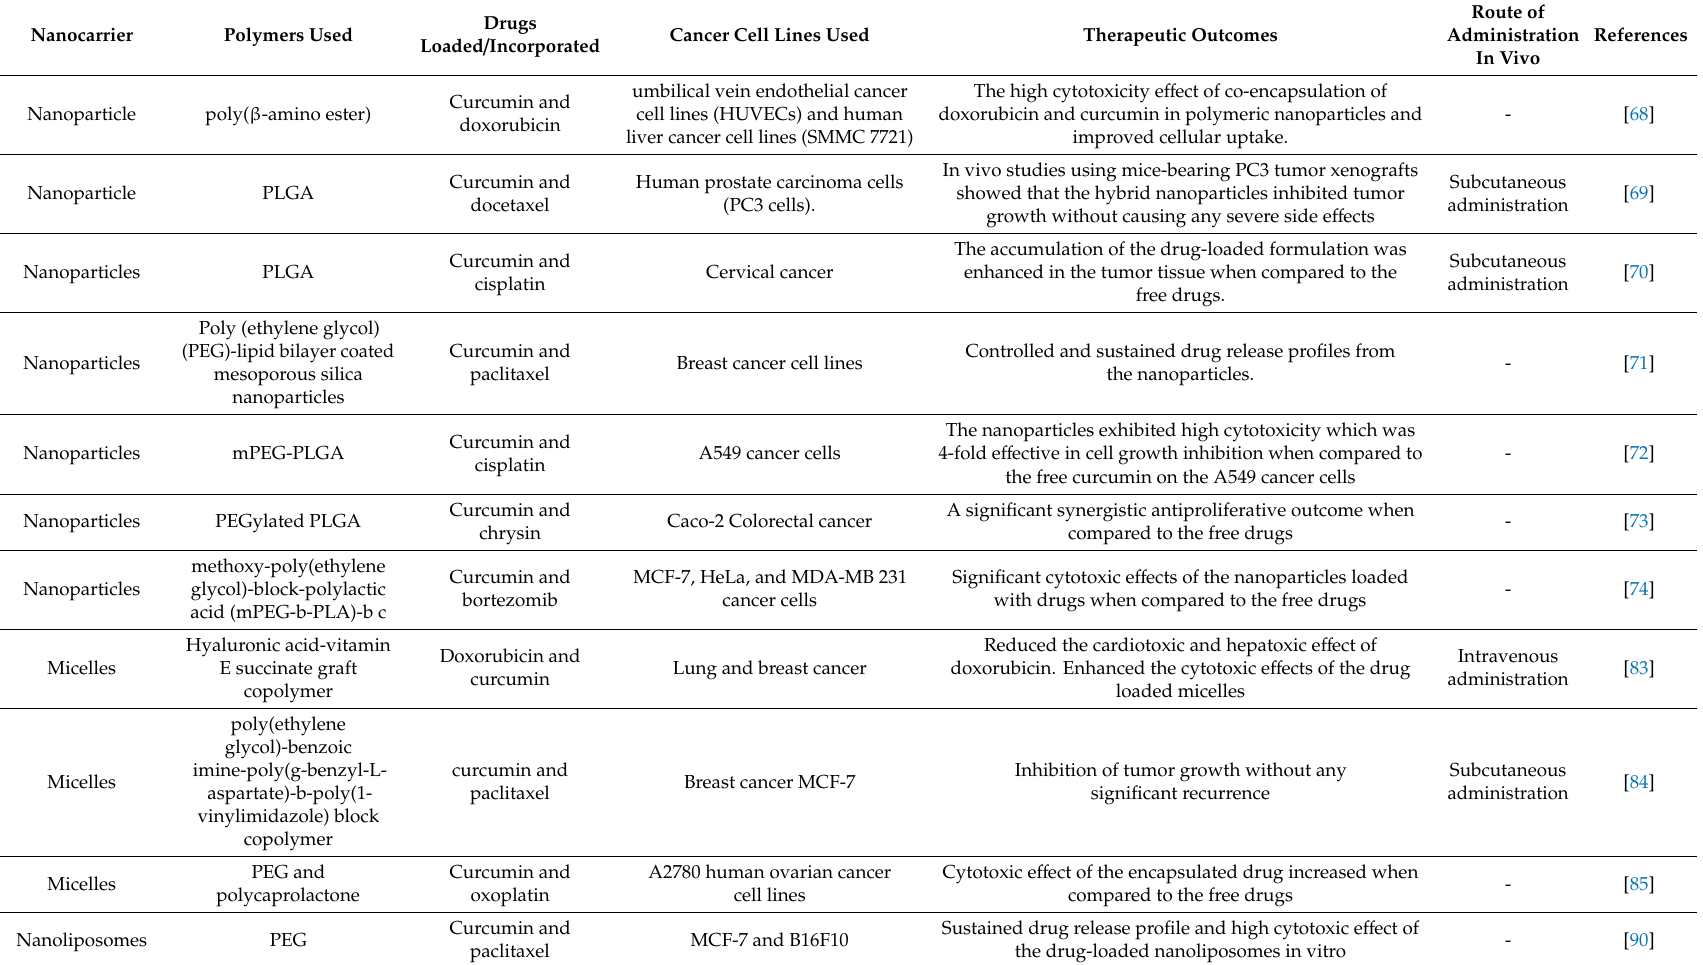
Table 2. A summary of nanocarriers loaded with a combination of curcumin and selected anticancer